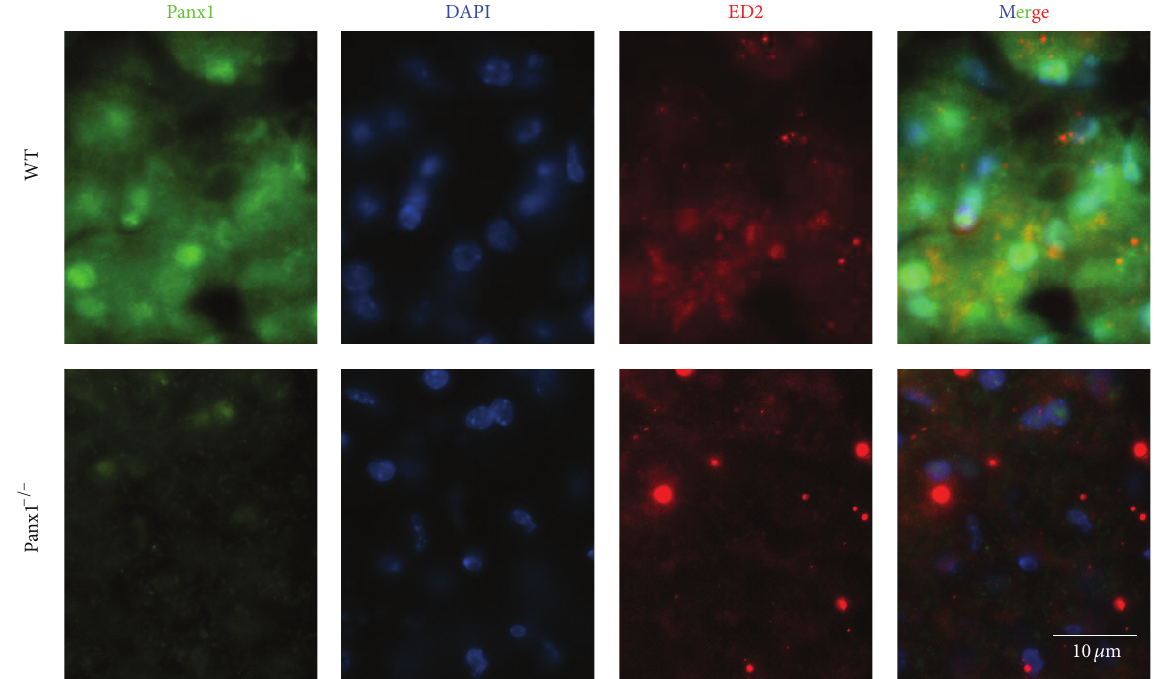
Figure 5: Expression of pannexin1 (Panx1) in Kupffer cells. Immunofluorescence analysis of liver cryosections (8 𝜇 m thick) obtained from adult wild-type (WT) and Panx1 −/− adult (C57/BL6) mice was performed to analyze reactivity of Panx1 (green, primary antibody: rabbit anti-Panx1 antibody and secondary antibody goat anti-rabbit IgG conjugated to FITC) in ED2 (red: goat polyclonal antibody and secondary antibody mouse anti-goat conjugated to Cy3) positive cells, which correspond to Kupffer cells. Top panels correspond to a liver section of a WT mouse and bottom panels correspond to a liver section of a Panx1 −/− mouse. No specific Panx1 reactivity was detected in Panx1 −/− liver, but ED2 positive cells were evident. DAPI stain was used to visualize nuclei (blue), and merge is also shown. Panx1 −/− mice were kindly donated by Dr. Hanna Monyer (University of Heidelberg, Germany). Bar: 10 𝜇